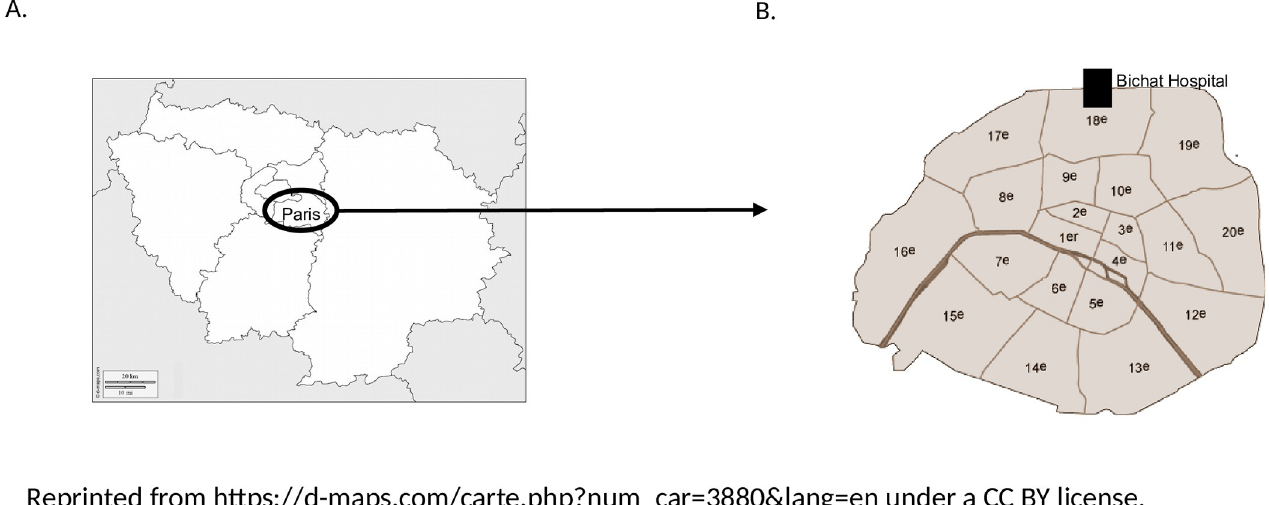
Fig 1. Geographical area of patients’ residence and poverty rates in Ile-de-France. Among the 4,796 patients participating in the study, 285 lived outside the Ile-de-France region, and no mailing addresses were found for 115 patients. The other patients lived in the Ile-de-France area and were distributed as follows: A. Ile-de-France region, excluding Paris: 2,234 patients where the poverty rate in 2016 was 14%. B. Paris city: 1,610 patients where the poverty rate was 16%; including the 18th arrondissement of Paris: 552 patients where the poverty rate was 24% [22,23].